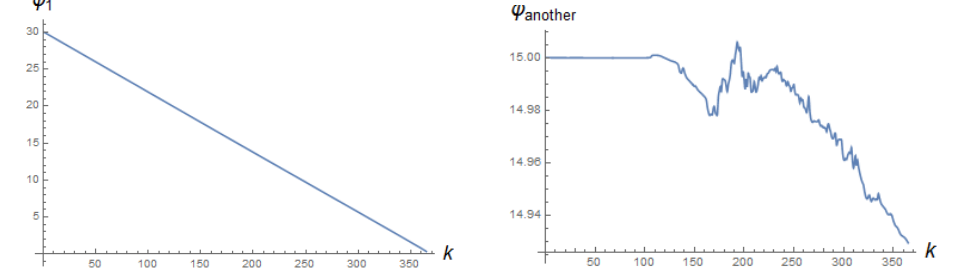
Figure 5 . The evolution of trajectories for dimension 20. In this case we choose the sigmoid activation function and we set (cid:11) = (cid:12) = 50, ! = 1, A = 10 (cid:0) 14 and h = 100. And also we set V rand = A h ( ’ 1 (cid:0) ’ max = 2 ; ( ’ i 6 =1 (cid:0) ’ max = 2) (cid:2) 10). We show the trajectories ’ 1 ( k ) (left) as a function of time step k for in(cid:13)aton, and ’ another ( k ) (left) for another light (cid:12)eld.